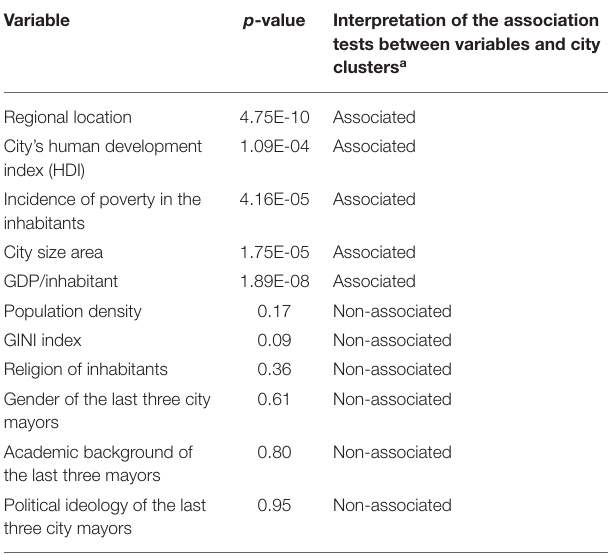
TABLE 1 | P -value results of Pearson’s chi-square association